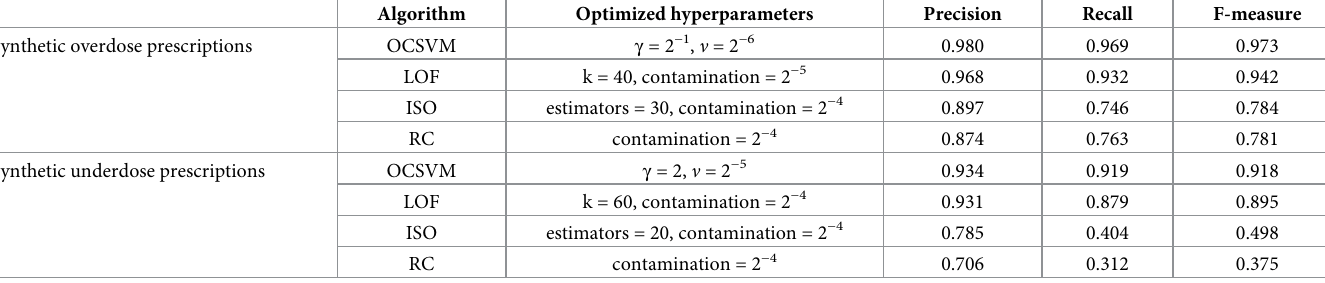
Table 5. Comparative analysis with unsupervised anomaly detection algorithms.